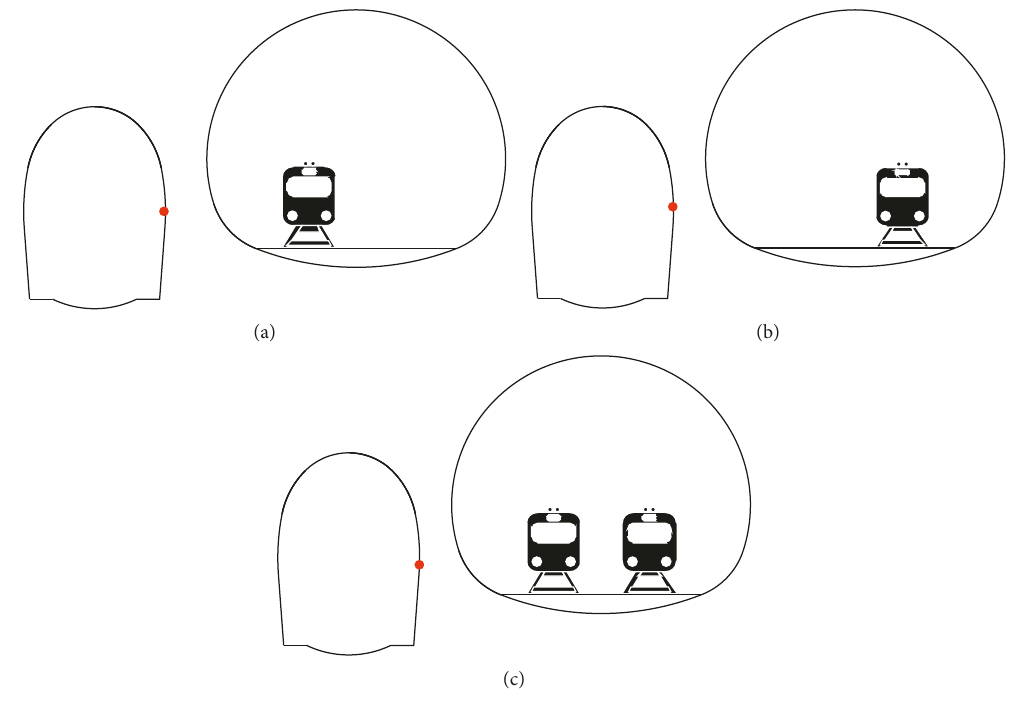
Figure 6: Sets of numerical simulation: (a) 1, (b) 2, and (c) 3.